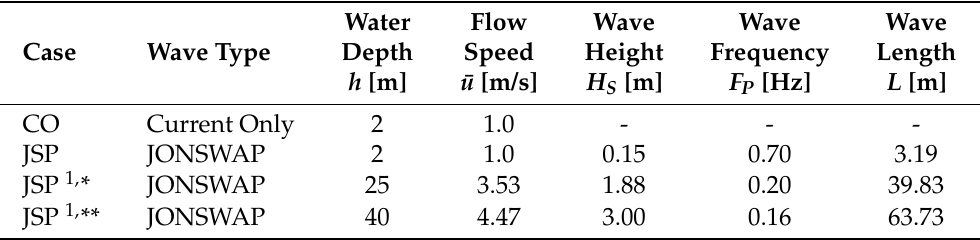
Table 1. Flow velocity and wave conditions utilised during the test campaign with full-scale equiva- lent wave characteristics